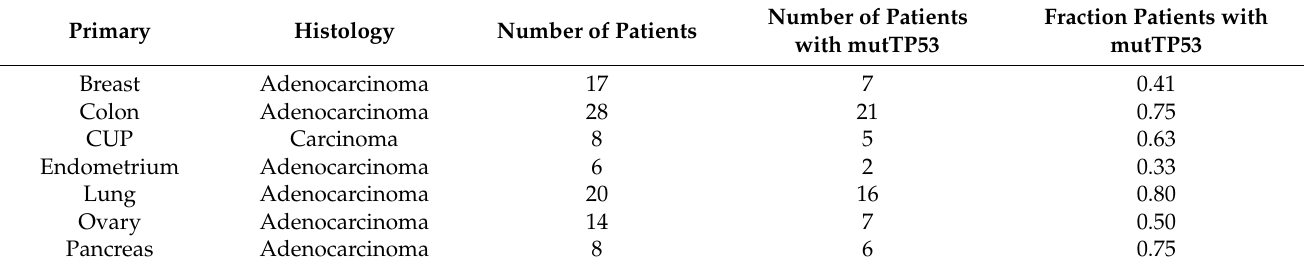
Table 2. Distribution of TP53 mutations among tumor types.